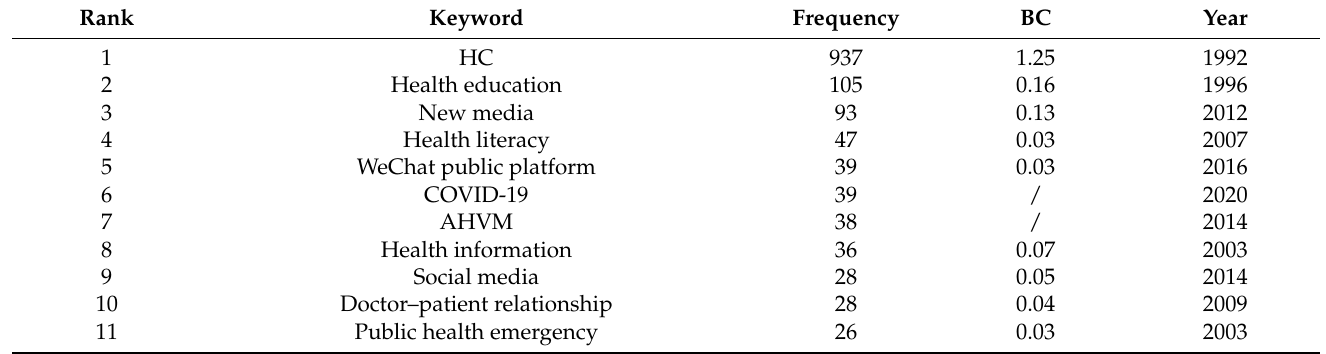
Table 4. Top 10 keywords in the field of HC in China.